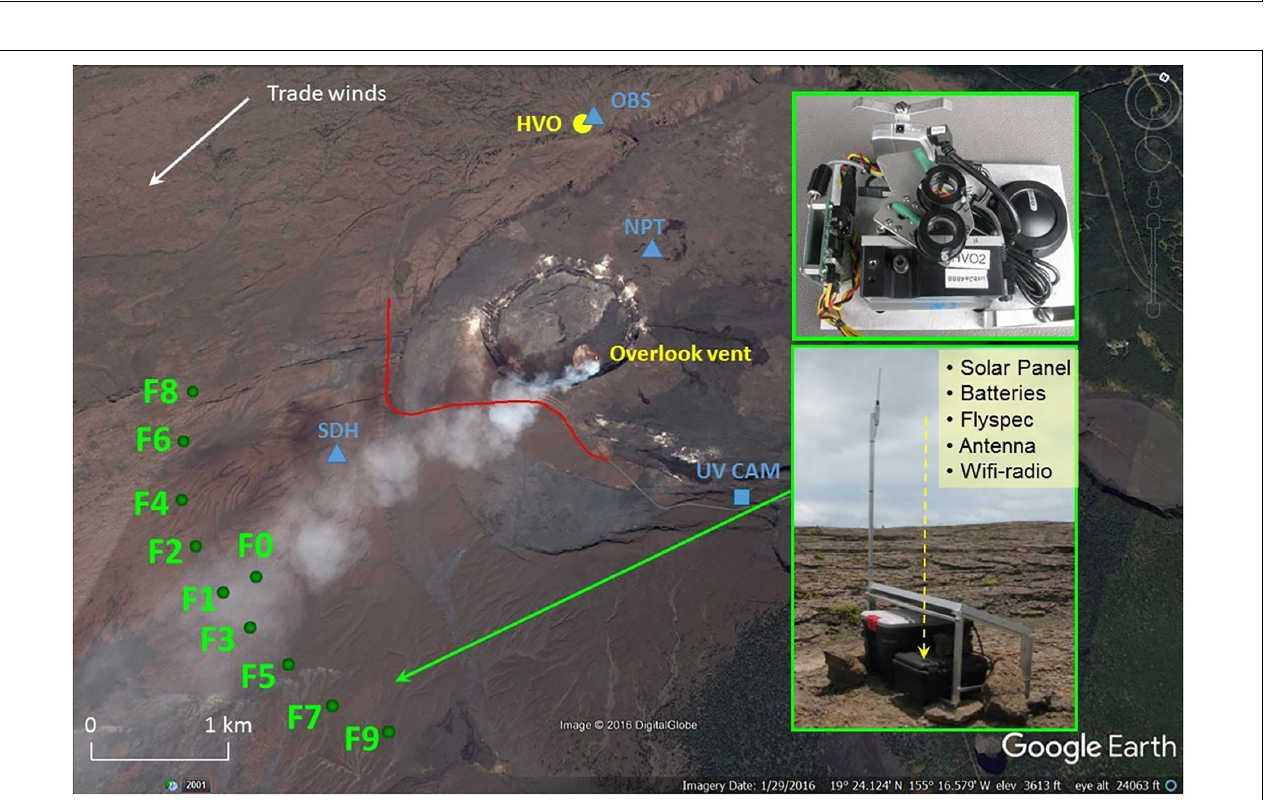
FIGURE 1 | Location of the main sources of SO 2 gas release at the summit and East Rift Zone of K¯ılauea Volcano from 2014 to 2017, with inset of vent locations on the Island of Hawai‘i. The traditional road traverses (red lines) are located downwind of the outgassing sources during the dominant trade wind conditions (arrow).